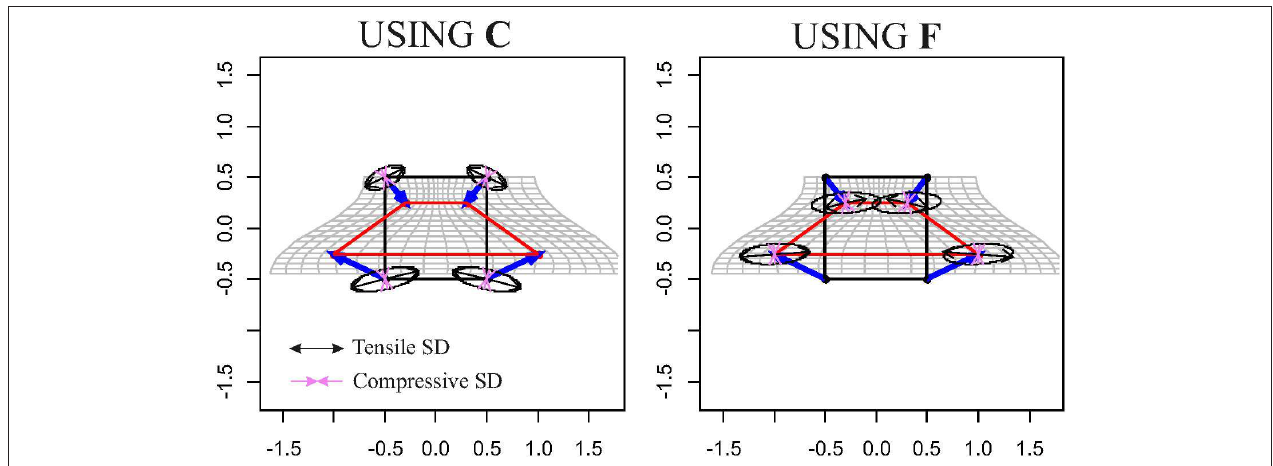
FIGURE 3 | Left panel : a bilinear transformation deforms the regular square into a trapezoid; √ C was used to compute local deformations at source vertices with displacement vectors (in blue). Right panel : the same with deformation ellipses evaluated on the target using F . Principal strain directions ( if tensile and in violet if compressive.